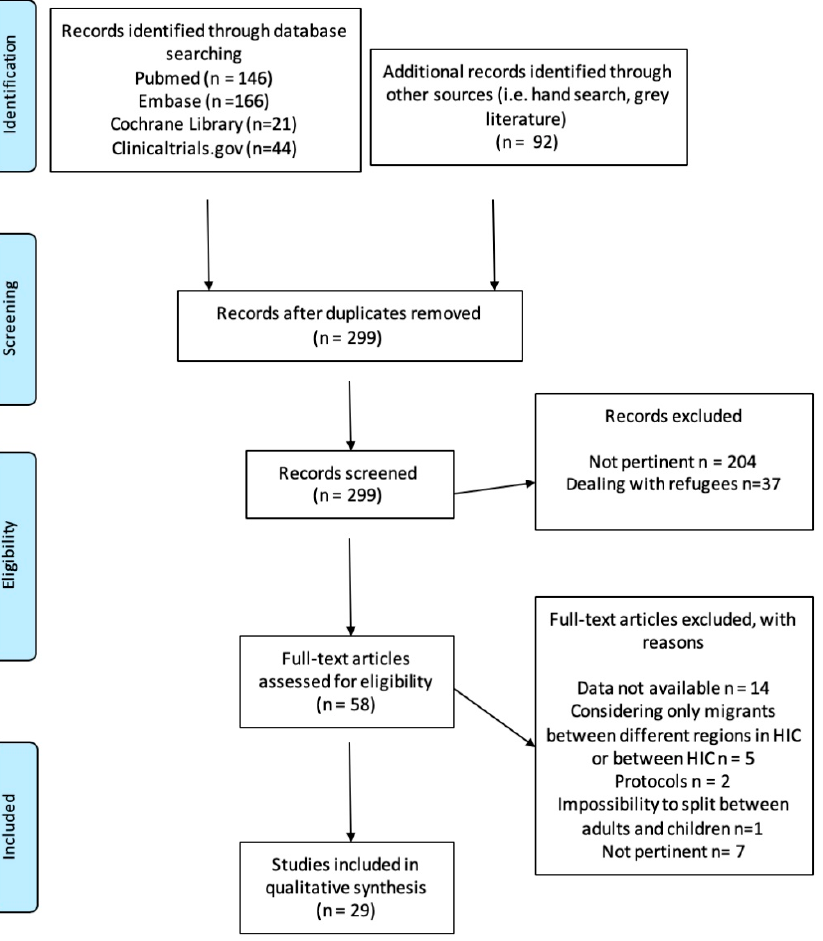
Figure 1. Preferred reporting items for systematic reviews and meta-analyses (PRISMA) 2009 Flow Diagram showing the process for articles selection [26]. HIC = high income countries.